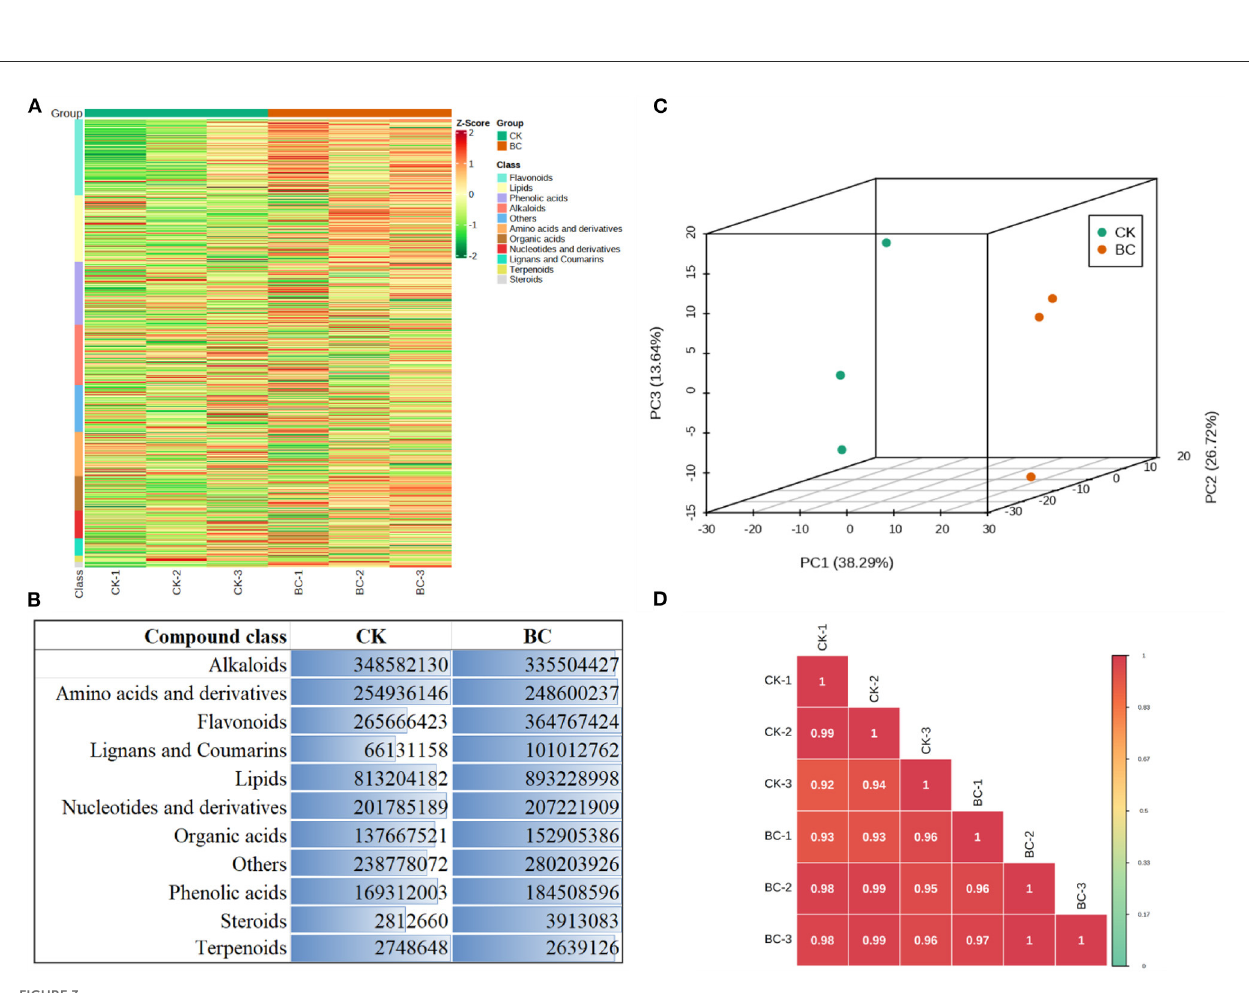
FIGURE3 Metabolome analysis of BC (30:1 v/v coconut bran and bamboo charcoal) and CK (100% coconut bran) leaves. (A) Heatmap of the relative intensities of the detected metabolites in CK vs. BC, (B) Sum of accumulated contents of metabolite classes in CK and BC, (C) Principal component analysis, and (D) Pearson’s Correlation Coefficient based on the relative metabolite intensities in CK vs.